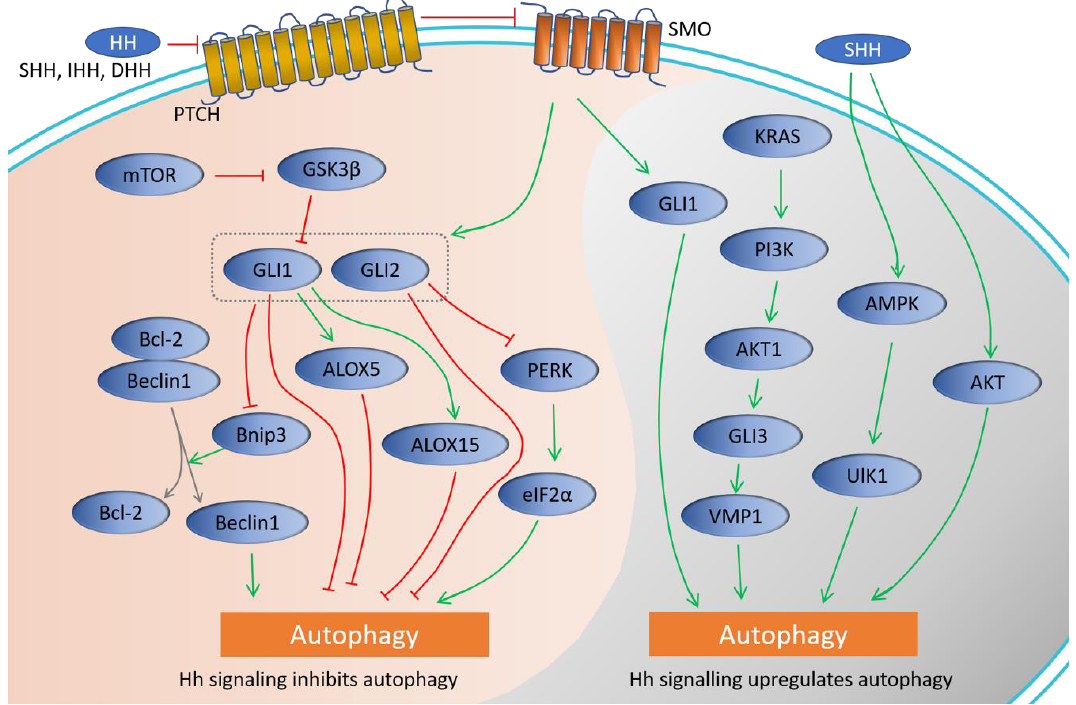
Figure 1. Crosstalk between Hh signaling and autophagy based on current evidence. Green arrow: upregulate; Red line: inhibit; Box with dash line: both GLI1 and GLI2 were involved in Bnip3 inhibition. Gray arrows: dissociation of Bcl-2/Beclin1 complex.